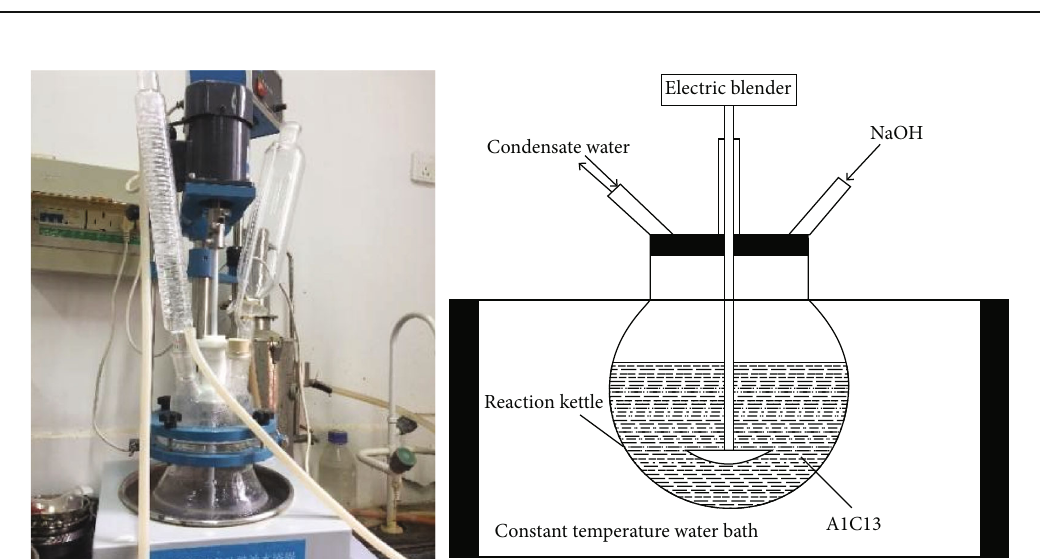
Figure 1: Device diagram and schematic diagram of the preparation of hydroxyl aluminum solution.